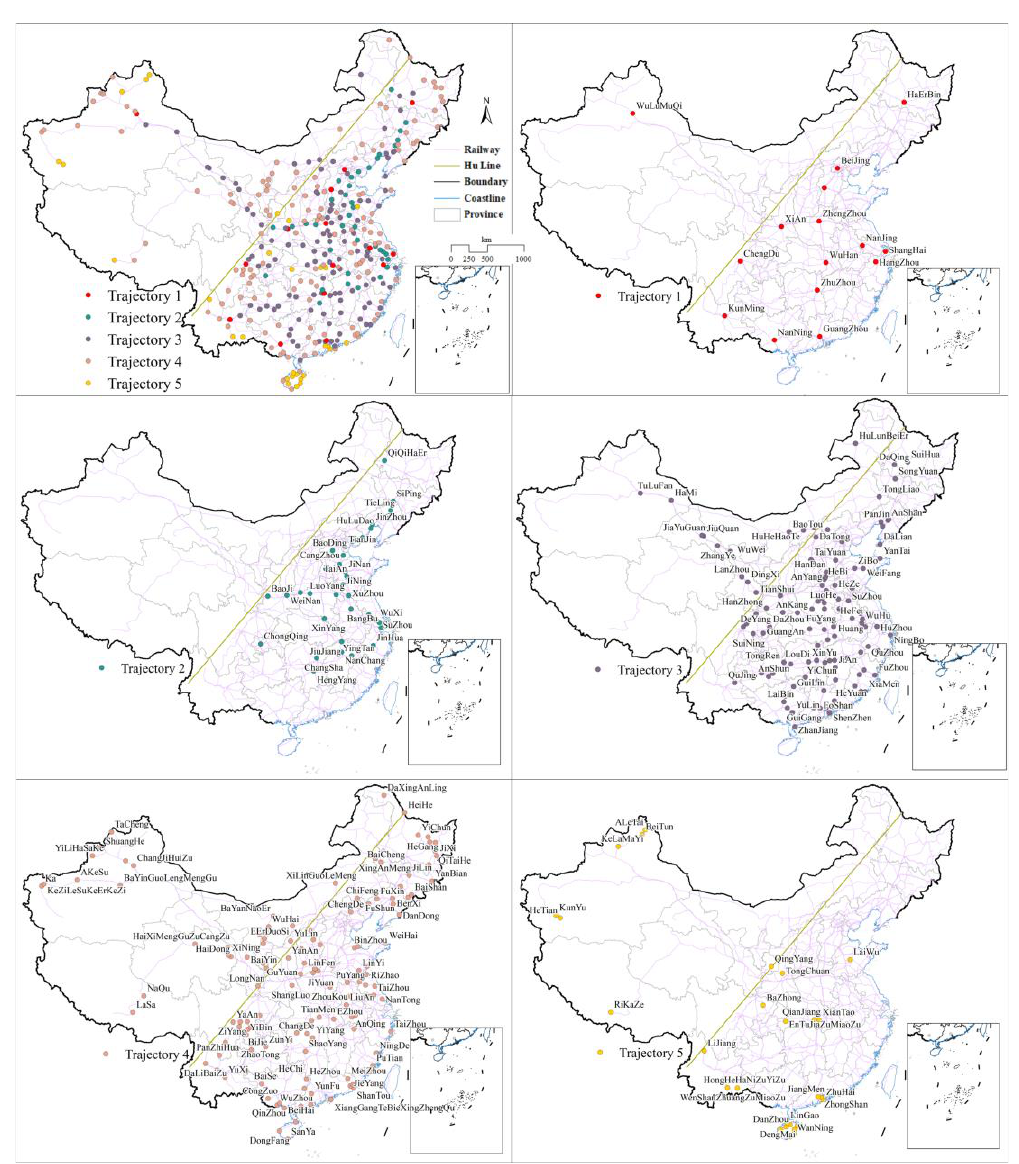
Figure 9. Clustering categories of the city nodes’ change trajectories.